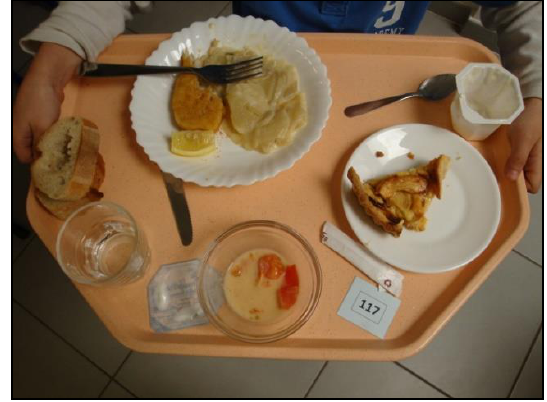
Figure 2. Example of the captured image of a disposed tray.